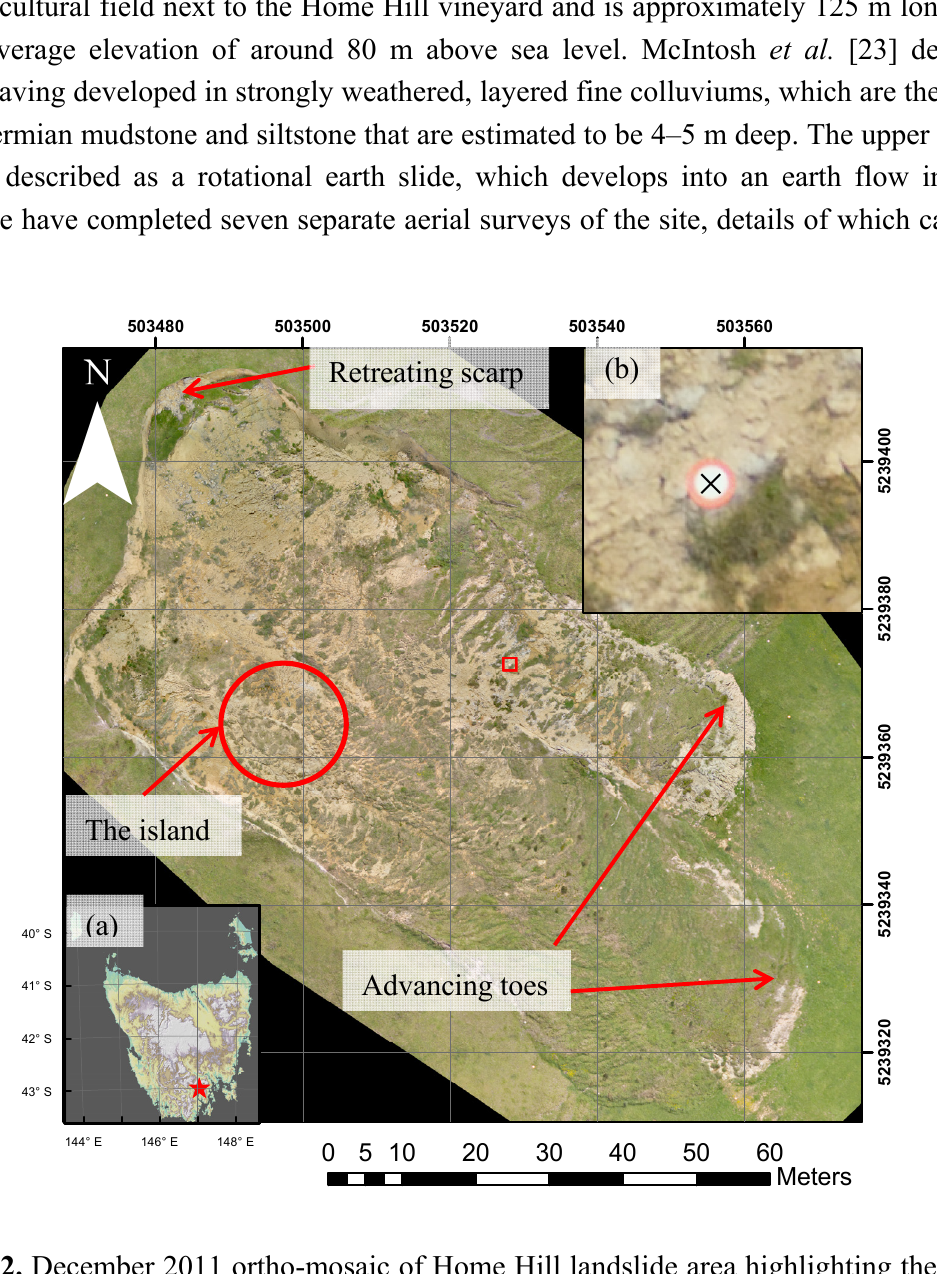
Figure 2. December 2011 ortho-mosaic of Home Hill landslide area highlighting the main features. ( a ) location map; ( b ) example of GCP with actual location marked with a black cross giving a typical example of absolute spatial errors (coordinate system: GDA94